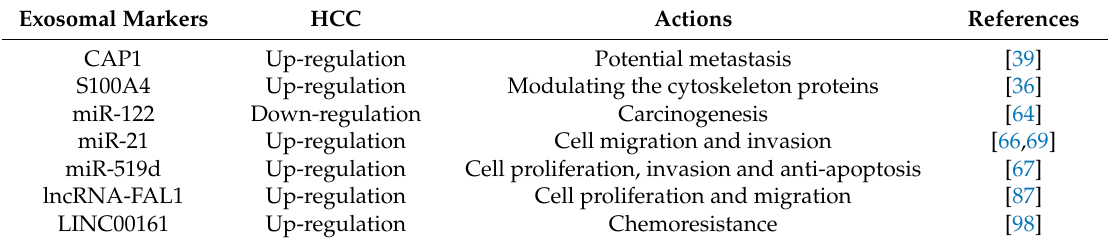
Table 1. Exosomal biomarkers for the detection of hepatocellular